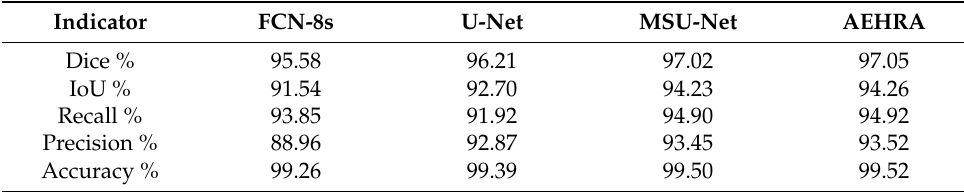
Table 3. Comparison of segmentation